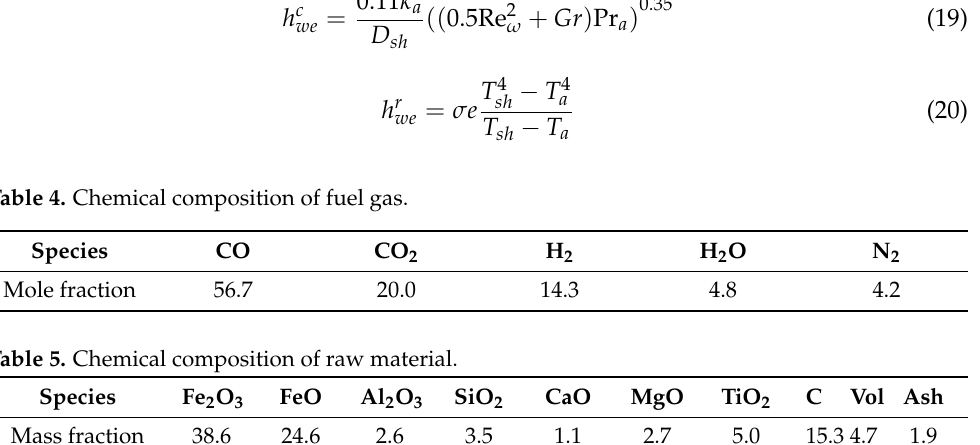
Figure 4. Computation mesh.